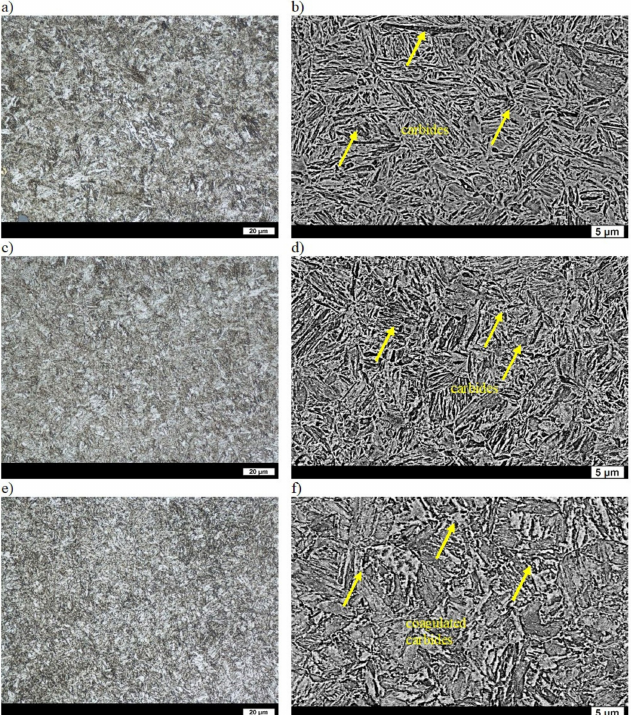
Figure 8. Microstructure of ingot No. 6 after quenching and tempering: ( a ) at 200 ◦ C, LM; ( b ) at 200 ◦ C, SEM; ( c ) at 400 ◦ C, LM; ( d ) at 400 ◦ C, SEM; ( e ) at 600 ◦ C, LM; ( f ) at 600 ◦ C, SEM. Etched with 3% HNO 3